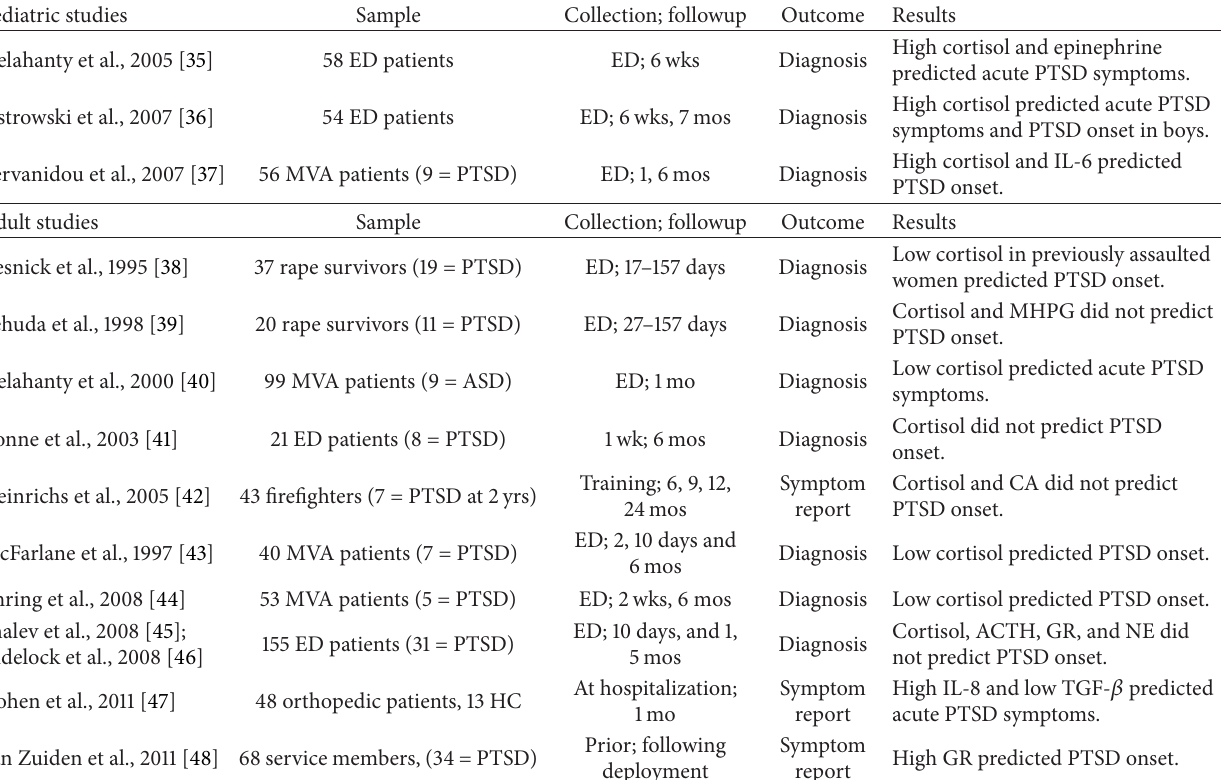
Table 3: Proteomic